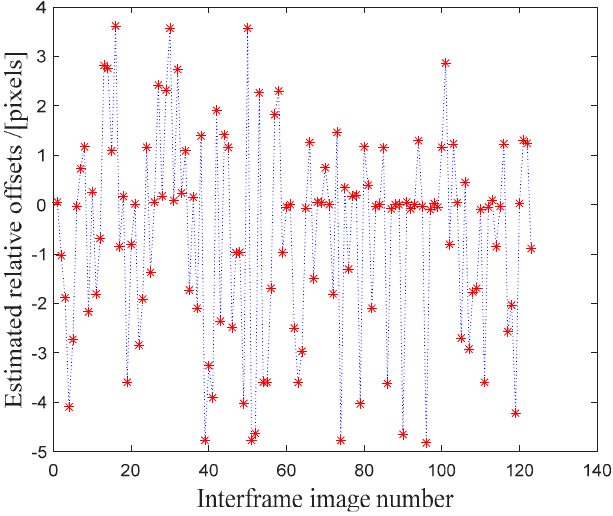
Figure 6. Subpixel “common” shift estimation and subtraction for a red square to obtain a relative shift. The sixth motion candidates across interframe images (between the first image and the others) from Lvshungang observation are taken as examples.